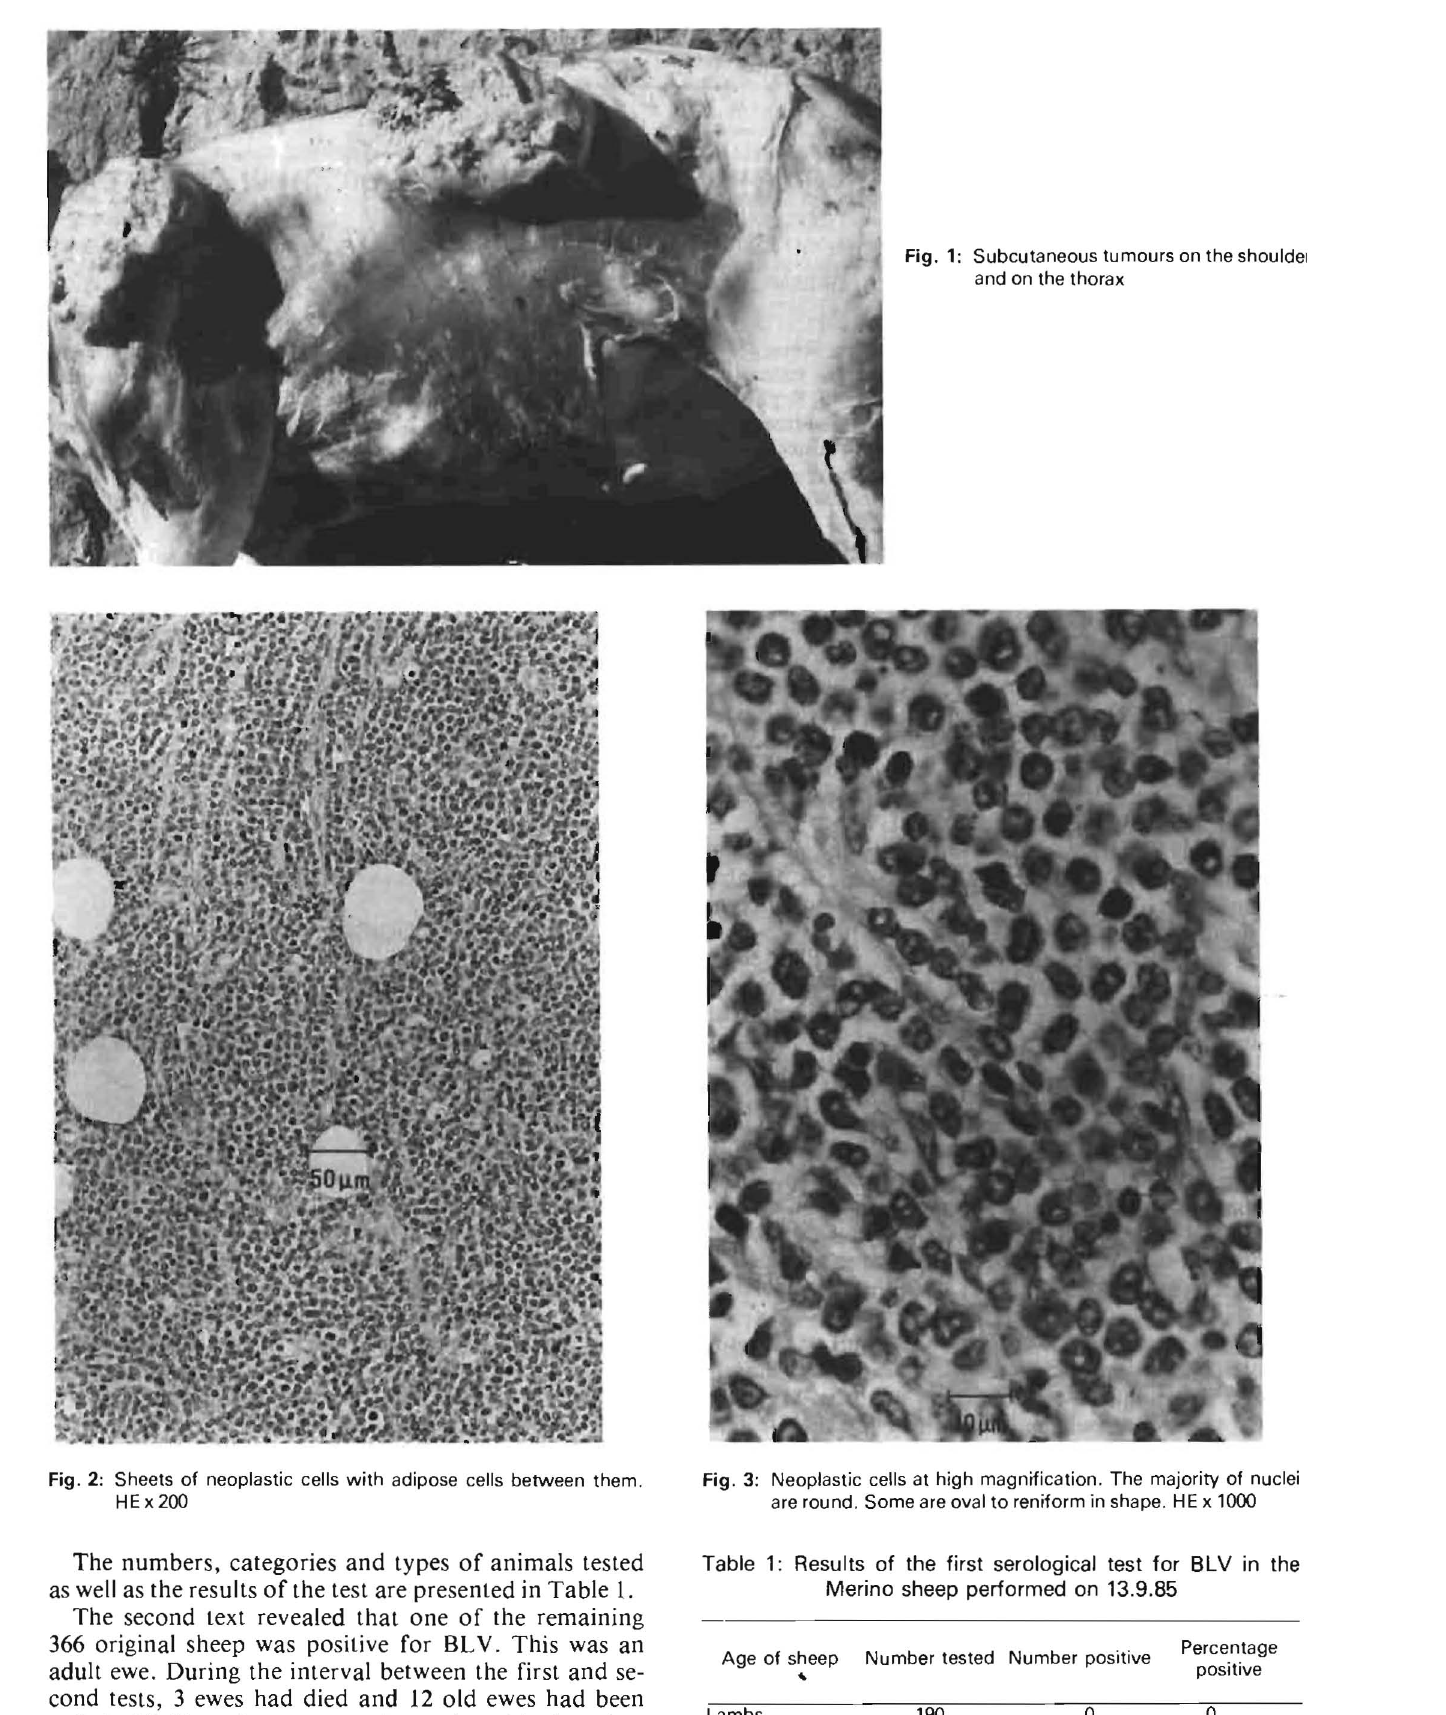
Fig. 3: Neoplastic cells at high magnification. The majority of nuclei are round. Some are oval to reniform in shape. HE x 1000 Table 1: Results of the first serological test for BLV in the Merino sheep performed on